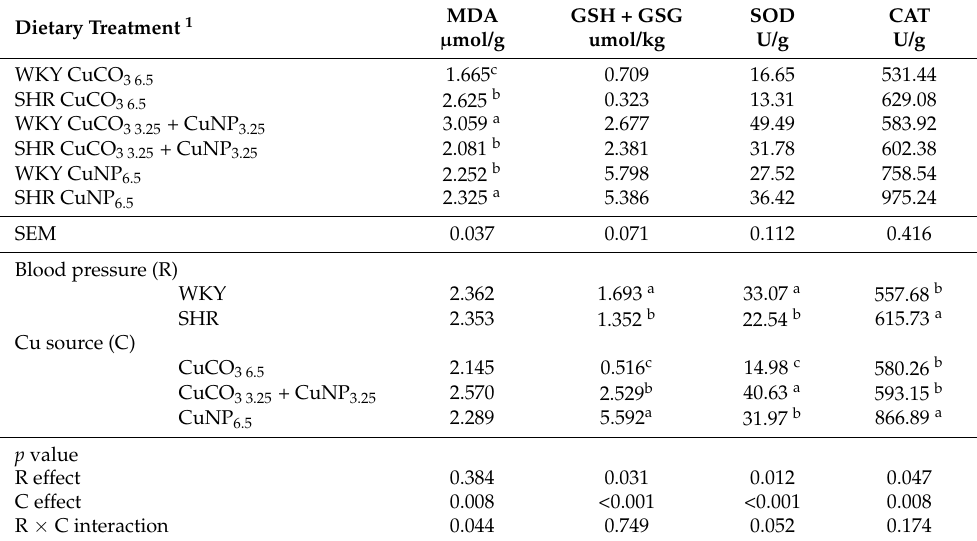
Table 4. Redox status in kidney tissue. Dietary Treatment